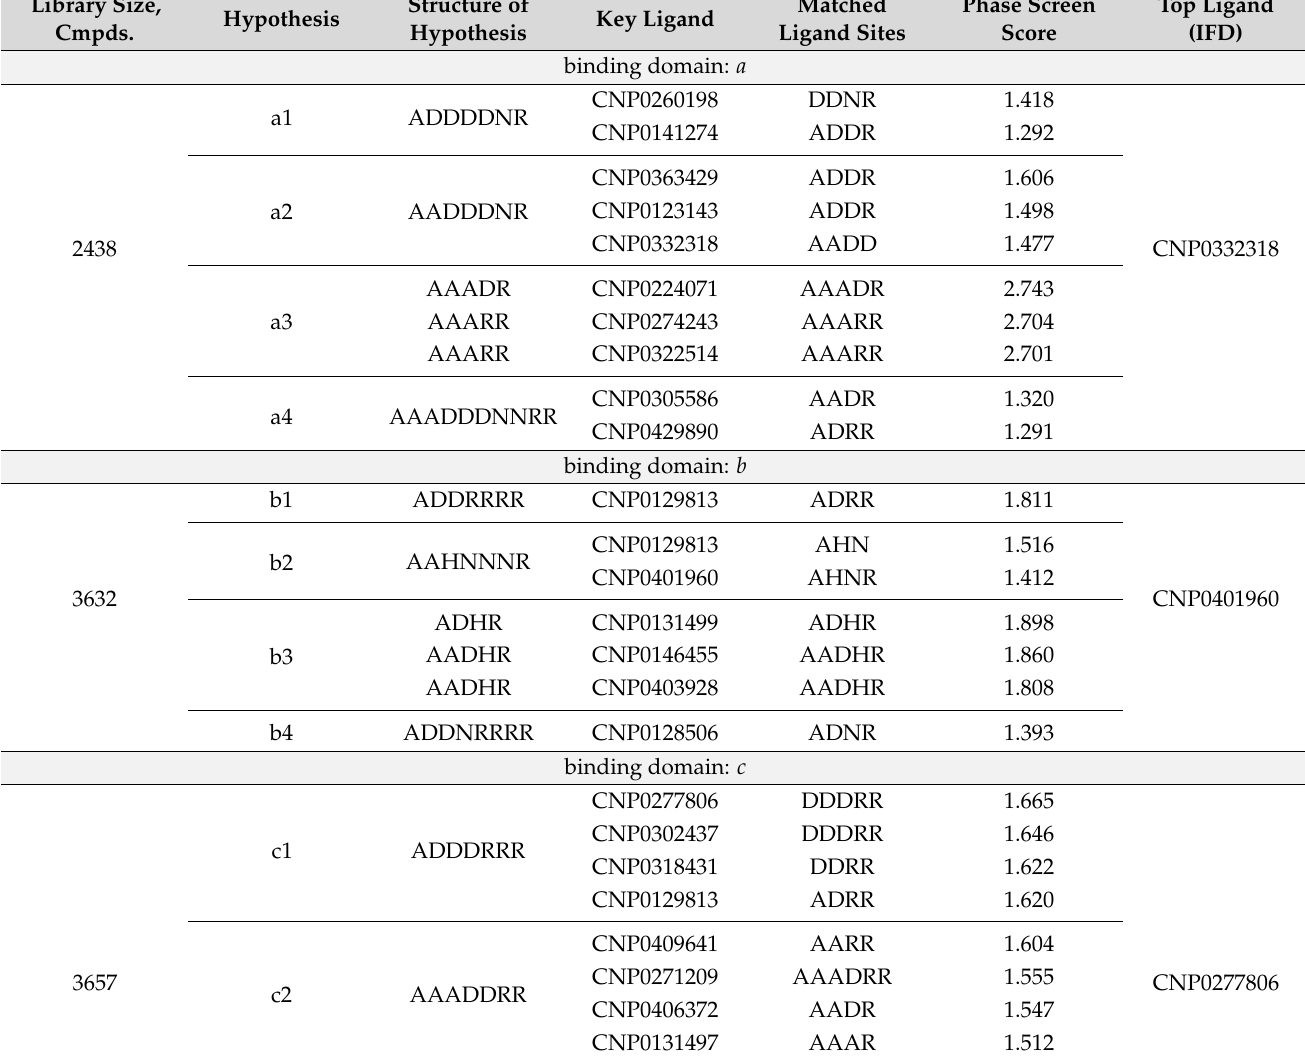
Table 3. Screening parameters for the key and top-ligands according to the pharmacophore models a – g . Library Size,